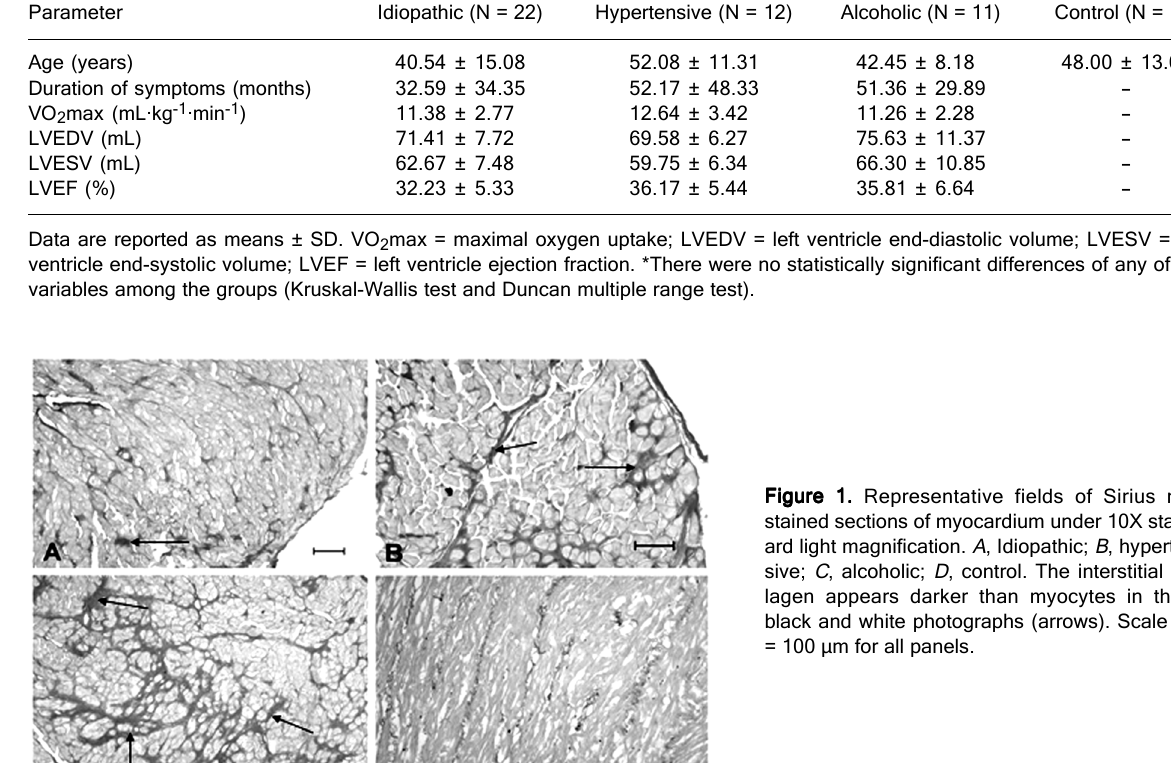
Figure 1. Representative fields of Sirius red- stained sections of myocardium under 10X stand- ard light magnification. A, Idiopathic; B, hyperten- sive; C, alcoholic; D, control. The interstitial col- lagen appears darker than myocytes in these black and white photographs (arrows). Scale bar = 100 µm for all